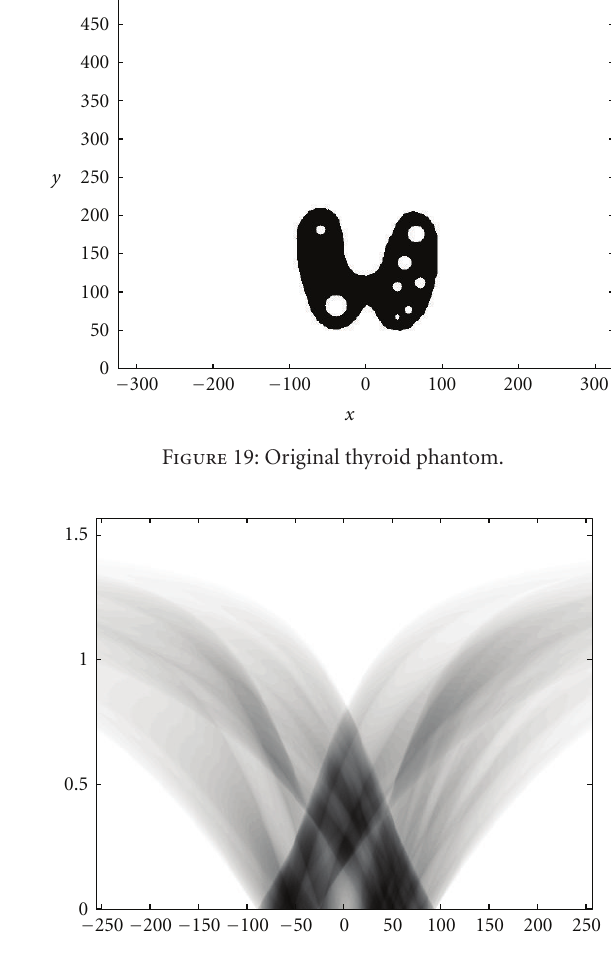
Figure 20: The T V transform of the thyroid image shown in Figure 19 with dω = 0 . 0025